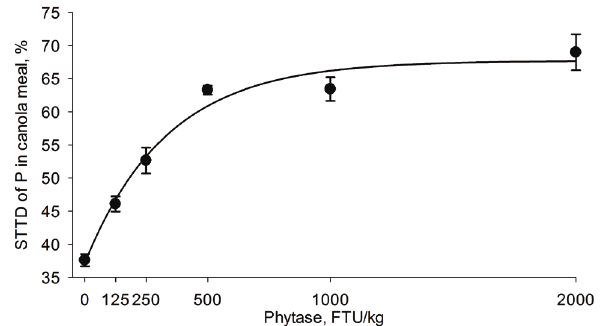
Figure 1. Fitted exponential model of standardized total tract digestibility (STTD) of P in canola meal as a function of concentration of exogenous phytase in the diet. Treatment means ( ● ) and standard error are shown. STTD of P = 37.2309+30.4873×[1–exp(–0.003 ×phytase dose in FTU/kg)], r 2 = 0.98, p<0.001. The concentration of phytase needed to maximize (i.e., to obtain 95% of the upper asymptote) the STTD of P at 64.3% was calculated to be 735 FTU/kg. FTU, phytase units.